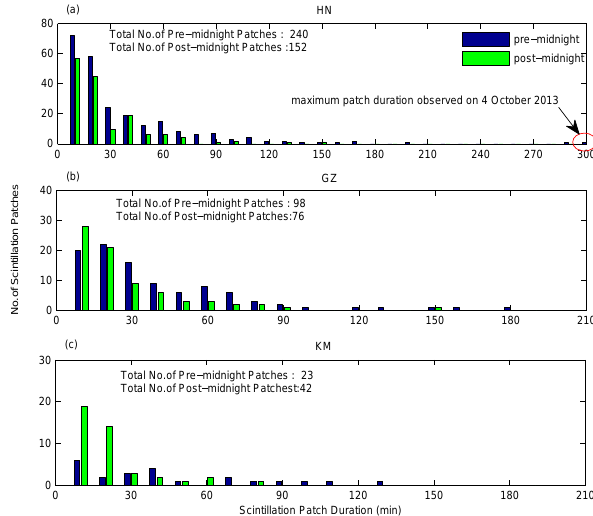
Figure 1. The temporal variations of S4 index of the scintillation events recorded at HN, GZ and KM on 16 April 2013. The local time is China standard time.